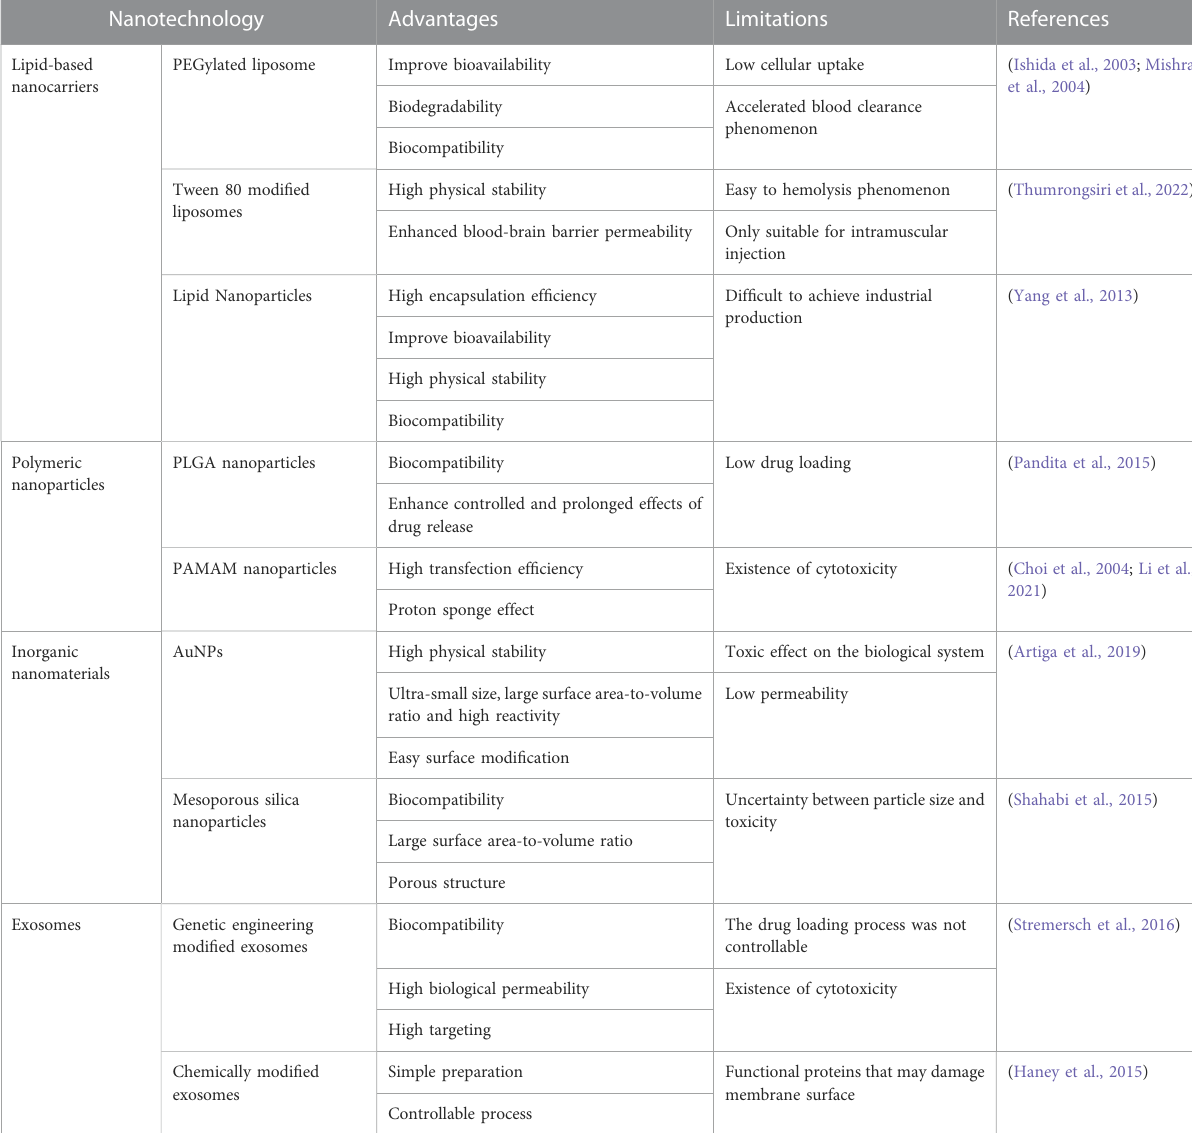
TABLE 1 Advantages and limitations of